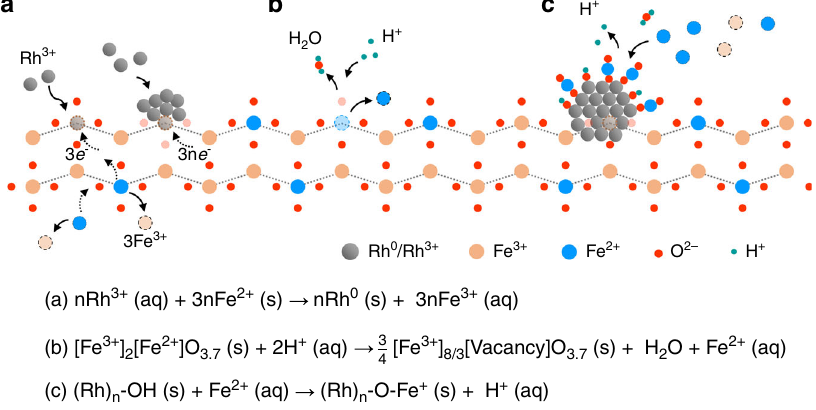
Fig. 2 Mechanism for synthesis of inverse FeO x /Rh/Fe 3 O 4 . Formation of Rh nanoparticles on Fe 3 O 4 and release of Fe 3 + by galvanic replacement ( a ), dissolution of Fe 2 + species ( b ), and selective deposition of Fe 2 + on Rh particles ( c